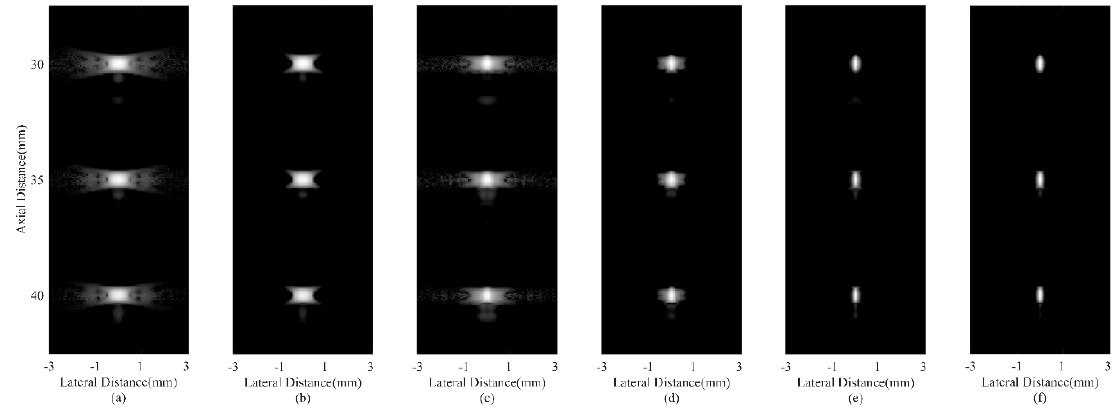
Figure 2. Simulated point targets using different beamformers: ( a ) DAS, ( b ) CF, ( c ) JTR-MV, ( d ) JTR-MV